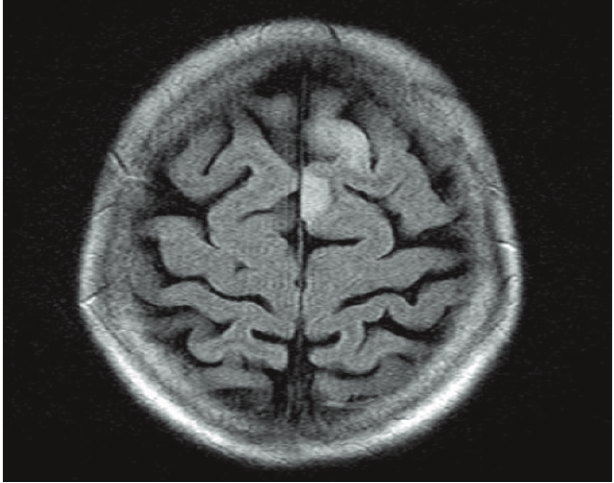
4a. FLAIR axial view shows 2 high-signal foci in the left frontal